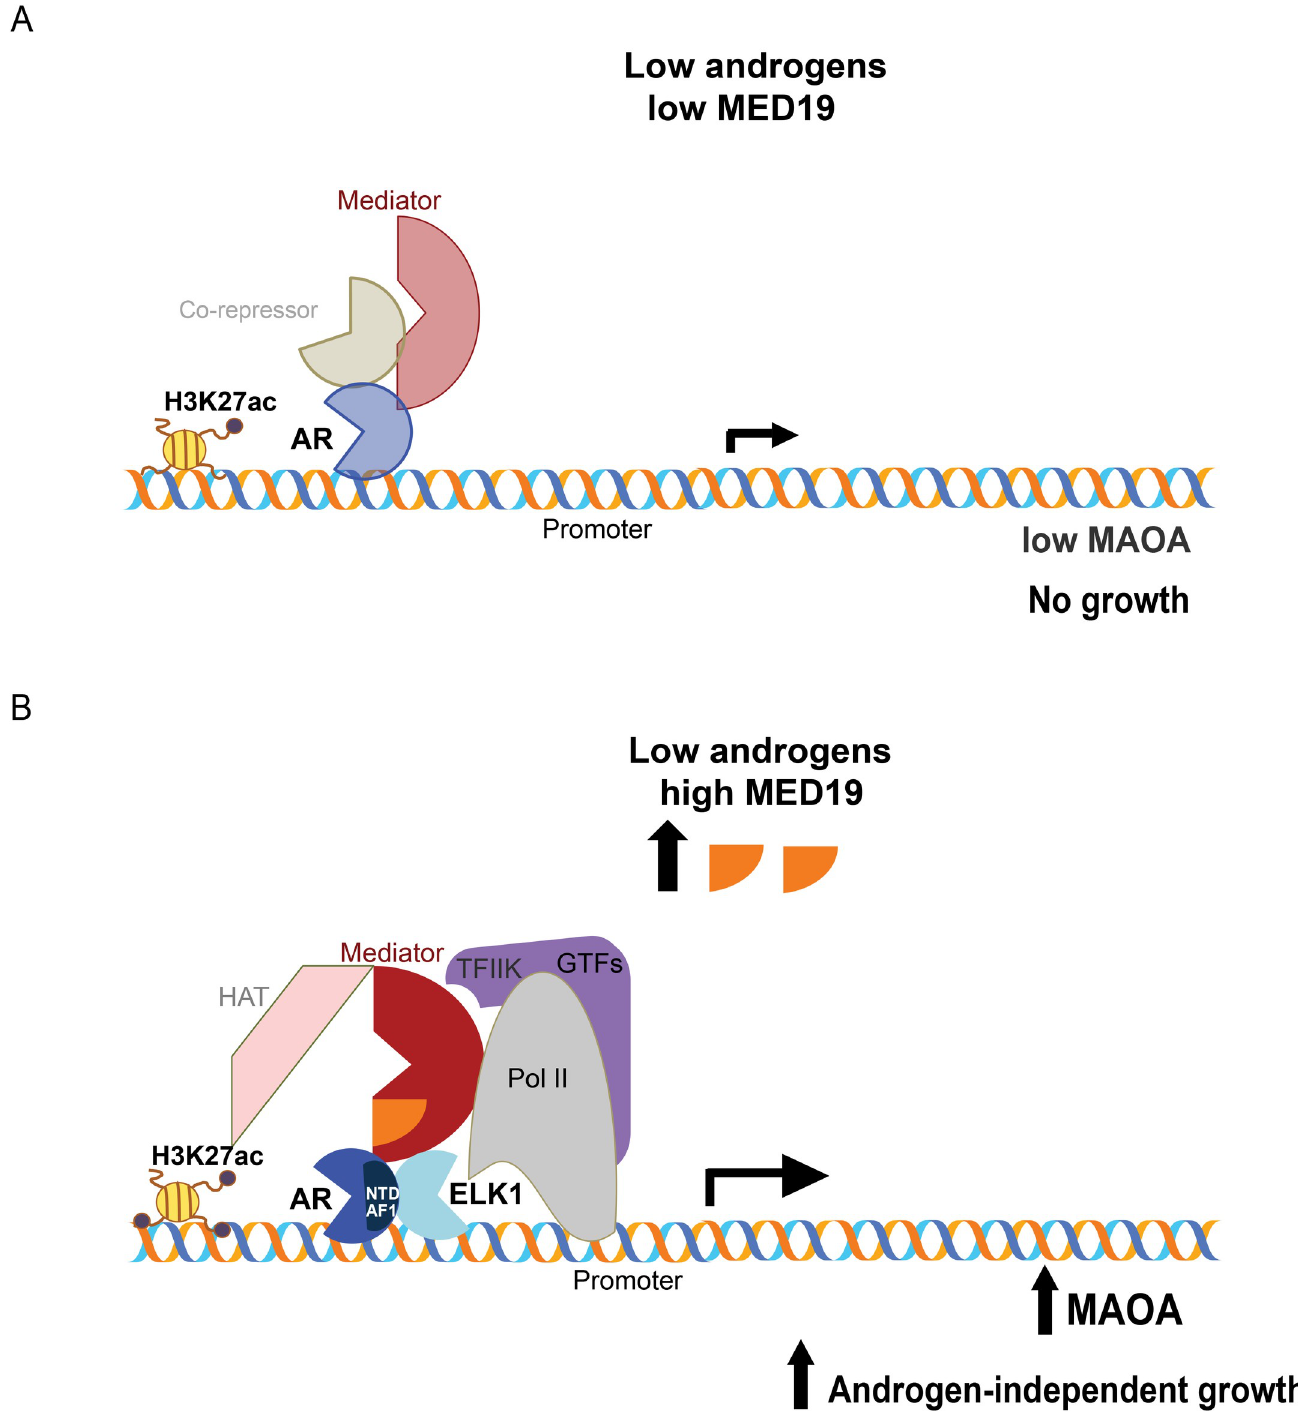
Fig 9. Model of MED19 driving androgen-independent growth by cooperating with ELK1 to promote AR occupancy and H3K27 acetylation at the MAOA promoter. A) Under low androgen and low MED19, AR occupancy is low at the MAOA promoter, MAOA is weakly expressed, and cells are growth-inhibited. B) When MED19 is upregulated, MED19 in Mediator cooperates with ELK1 to recruit and stabilize AR via its N-terminal domain (NTD) at the MAOA promoter, also recruiting Pol II and HATs, upregulating MAOA expression, and driving androgen-independent growth.